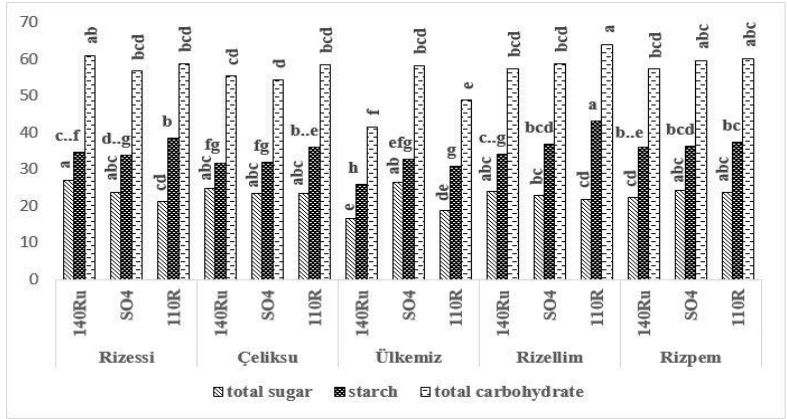
Figure 4. Graft area carbohydrate accumulations in grafted vine saplings. total sugar p < 0.01 LSD: 3.88, starch p < 0.01 LSD: 3.48, total carbohydrates p < 0.01 LSD: 5.06. a – g: differences between results shown with different letters in the same designs are statistically significant.